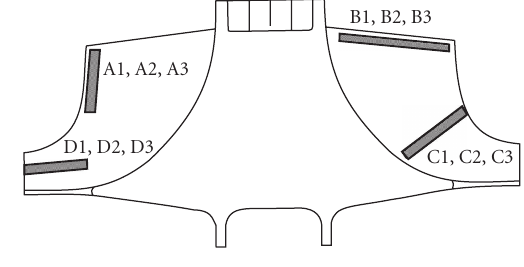
Figure 1: Locations of the specimens.